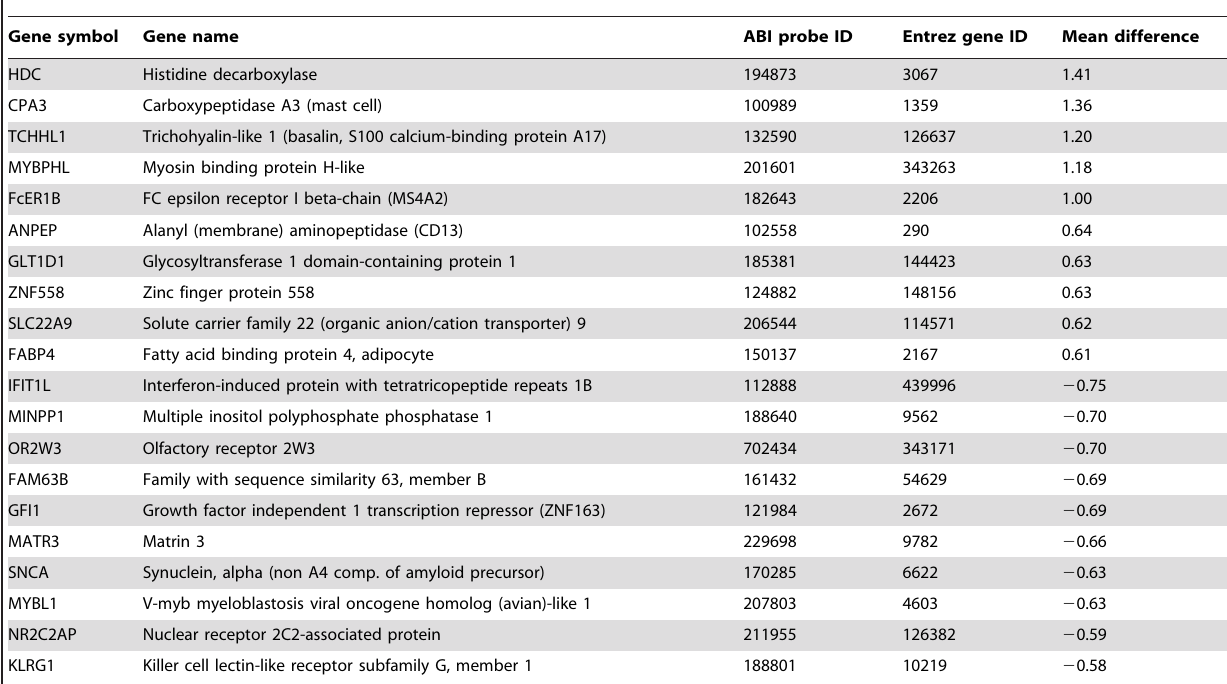
Table 4. Top 10 up- and down-regulated genes associated with LA/ALA ratio (p # 0.01) a .